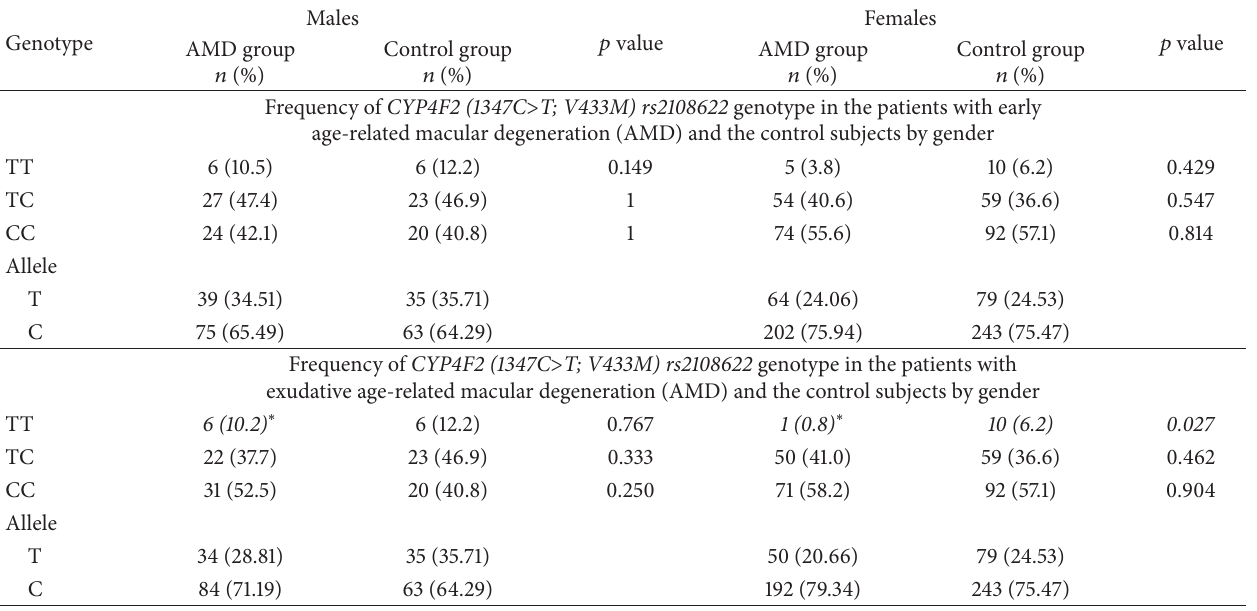
Table 5: Frequency of CYP4F2 rs2108622 genotype in the patients with early AMD and eAMD and the control subjects by gender. Genotype